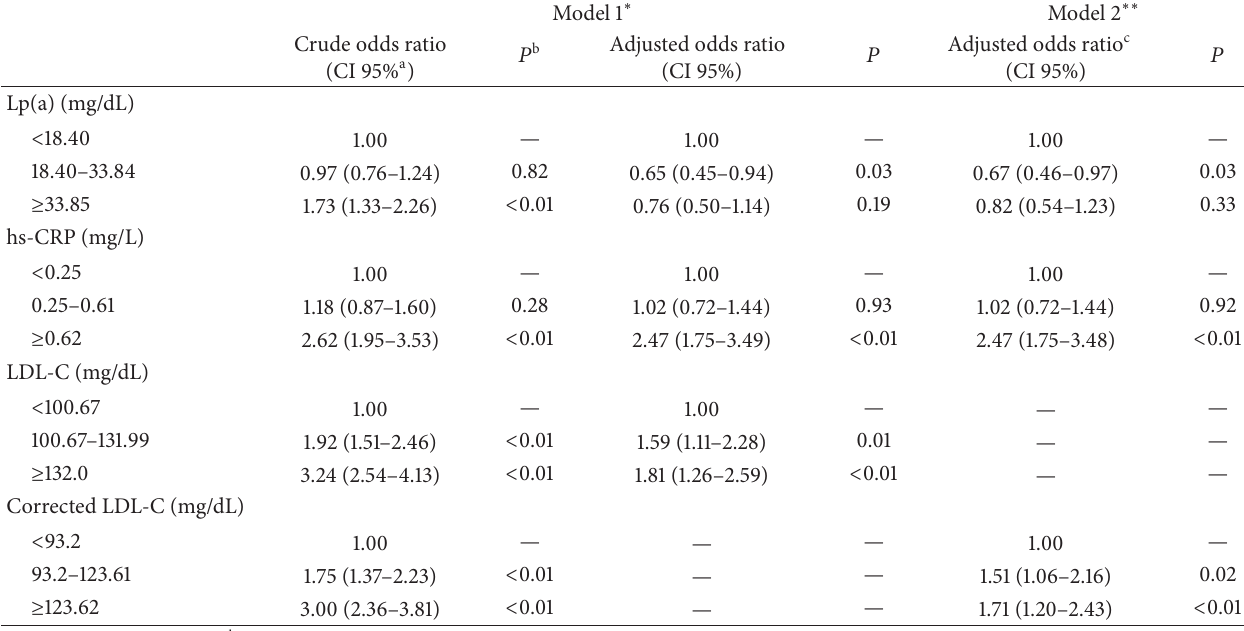
Table 7: Logistic regression model of risk factors for the metabolic syndrome. The Maracaibo City Metabolic Syndrome Prevalence Study, 2013. Model 1 ∗ Model 2 ∗∗ Crude odds ratio (CI 95% a )